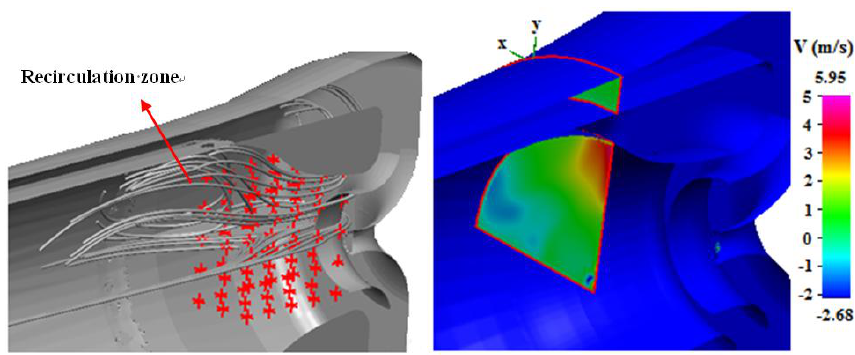
Figure 10. Recirculation